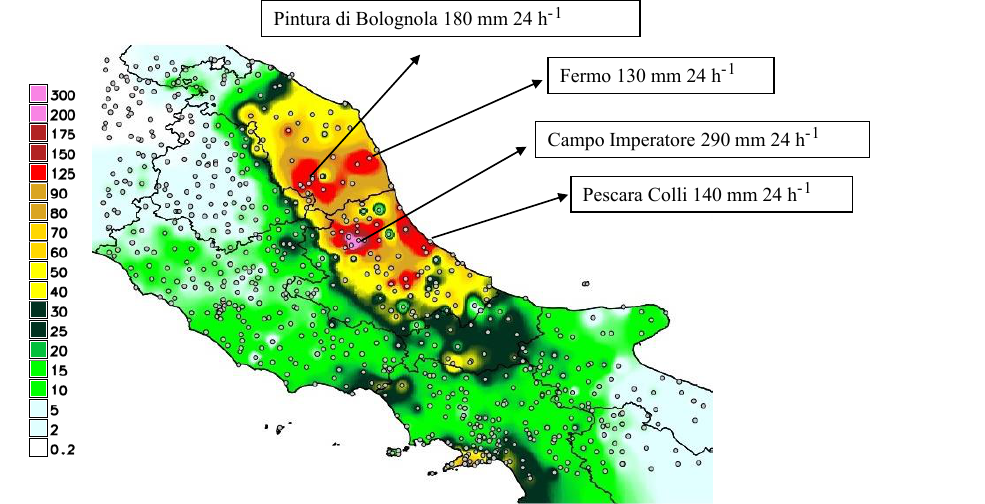
Figure 3. Spatial interpolation of precipitations measured by a rain gauge network (mm24h − 1 ) from 14 September 00:00UTC to 15 September 00:00UTC. The rain gauge stations (dots) with significant precipitation amounts are highlighted by black